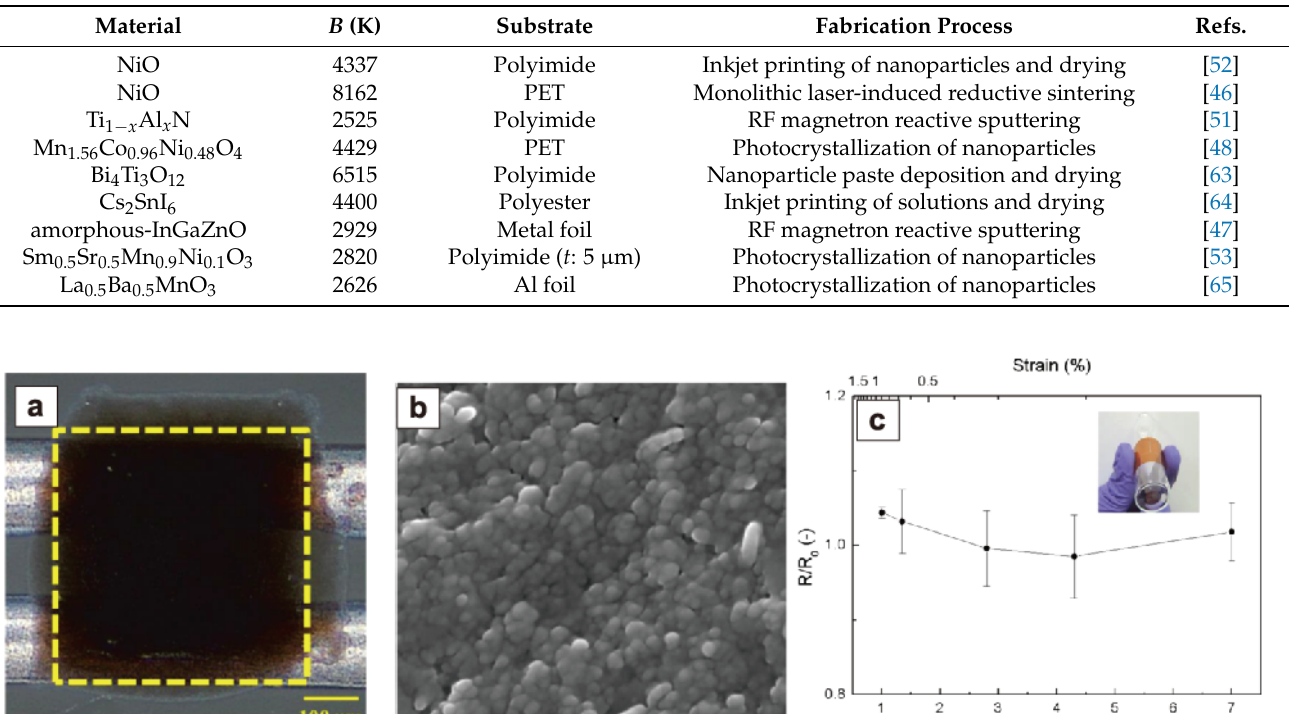
Table 1. The B constant, substrate, and fabrication process for flexible thermistors that have recently been reported.